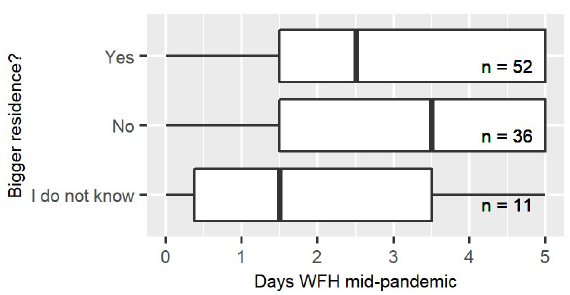
Figure 6. Willingness to move for increased residence size given the possibility to telecommute in respect to number of days telecommuting